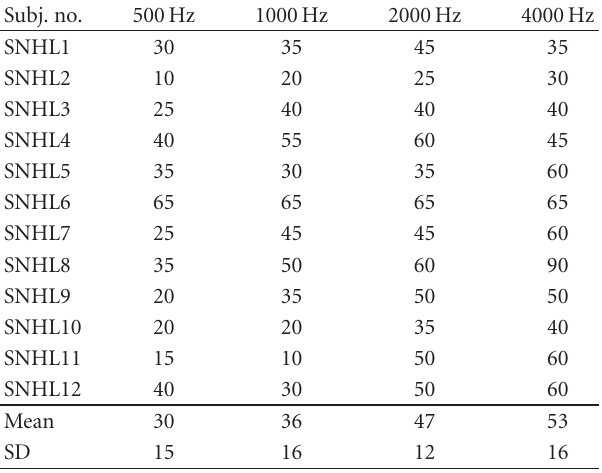
Table 1: Pure-tone behavioural hearing thresholds (test ear, in dBHL) of the SNHL